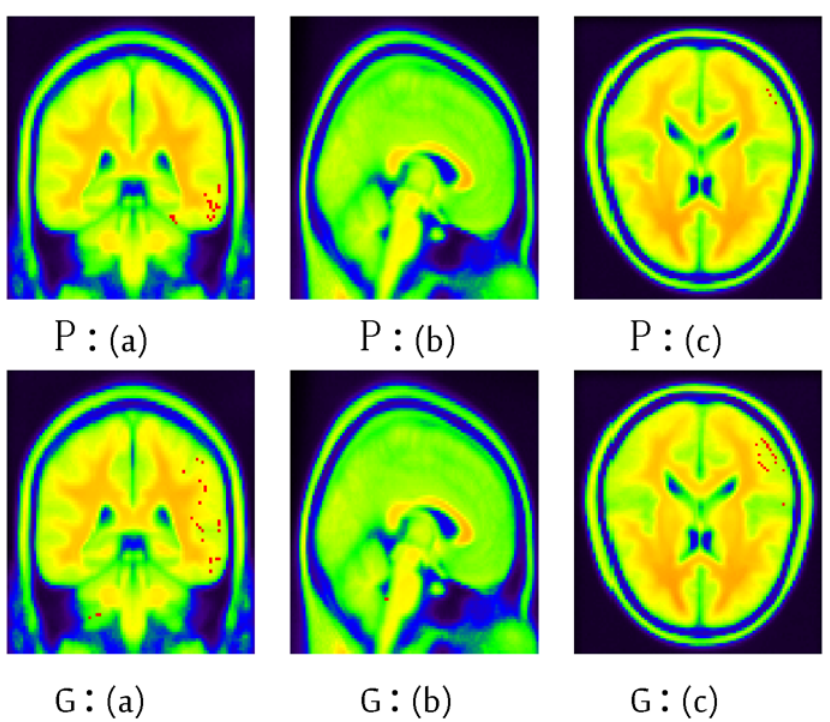
Fig 8. The informative regions (voxels) of MCI against AD using TUM dataset of the 45th layer using BIC. (a): coronal view (b): sagittal view (c): transaxial view. P: primary sensorimotor cortex normalization; G: grand mean normalization. x , y and z are the width (91), depth (109) and height (91) respectively. The red points represent the informative voxels, whereas other colors are only used to depict the brain